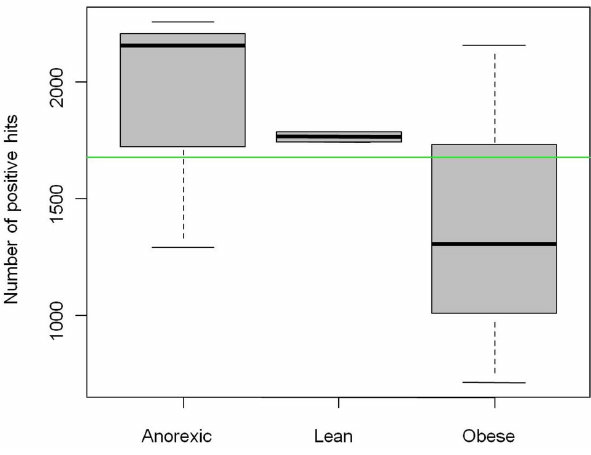
Figure 1. Boxplots of detected CAZyme genes among sample groups. Each box plot diagram indicates the variation of the number of detected genes within sample groups (lean, anorexic and obese). The horizontal black lines inside the box plots indicate the mean number of detected CAZyme gene within the group sample. The horizontal green line indicates the overall mean of detected genes in the eight samples.